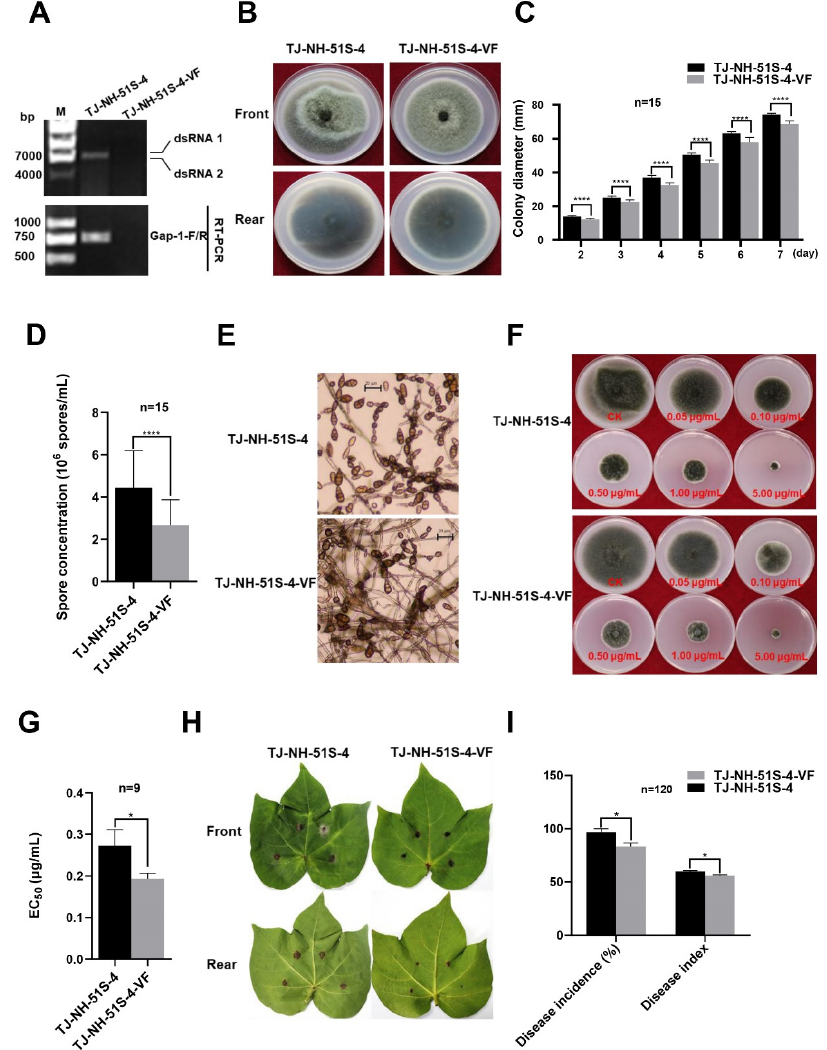
Figure 2. Colony morphology, colony growth rate, spore production, sensitivity to difenoconazole, and virulence of Alternaria tenuissima strains TJ-NH-51S-4 and TJ-NH-51S-4-VF. ( A ) Confirmation of the presence or absence of Alternaria alternata botybirnavirus 1-AT1 (AaBRV1-AT1) in strains TJ-NH-51S-4 and TJ-NH-51S-4-VF, respectively, by dsRNA profiles (top) from the two strains using agarose gel electrophoresis (M: λ - Hin d III digest DNA marker) and RT-PCR analysis using virus- specific primers (bottom) (M: DNA molecular marker DL 2000). ( B ) Colony morphology of strains TJ-NH-51S-4 and TJ-NH-51S-4-VF cultured on potato dextrose agar (PDA) plates at 25 ◦ C for 7 d in darkness. ( C ) Colony diameter measured over 2 − 7 d of strains TJ-NH-51S-4 and TJ-NH-51S-4-VF cultured on PDA plates at 25 ◦ C in darkness. ( D ) Conidiophores produced by strains TJ-NH-51S-4 and TJ-NH-51S-4-VF cultured on PDA plates at 25 ◦ C for 7 d in darkness as viewed with a Nikon Eclipse Ci microscope. ( E ) Spore concentration in strains TJ-NH-51S-4 and TJ-NH-51S-4-VF cultured on PDA plates at 25 ◦ C for 7 d in darkness. ( F ) Effect of difenoconazole on colony growth of strains TJ- NH-51S-4 and TJ-NH-51S-4-VF. ( G ) Median effective concentration (EC 50 ) of difenoconazole against strains TJ-NH-51S-4 and TJ-NH-51S-4-VF. ( H ) Disease symptoms on cotton leaves inoculated with strains TJ-NH-51S-4 and TJ-NH-51S-4-VF at 7 d post inoculation. ( I ) Disease incidence and disease index on cotton leaves inoculated with strains TJ-NH-51S-4 and TJ-NH-51S-4-VF. Stars indicate different levels of significant difference between the two strains as determined by paired t -test using Graphpad Prism version 8.0 software (*, p < 0.05; ****, p <